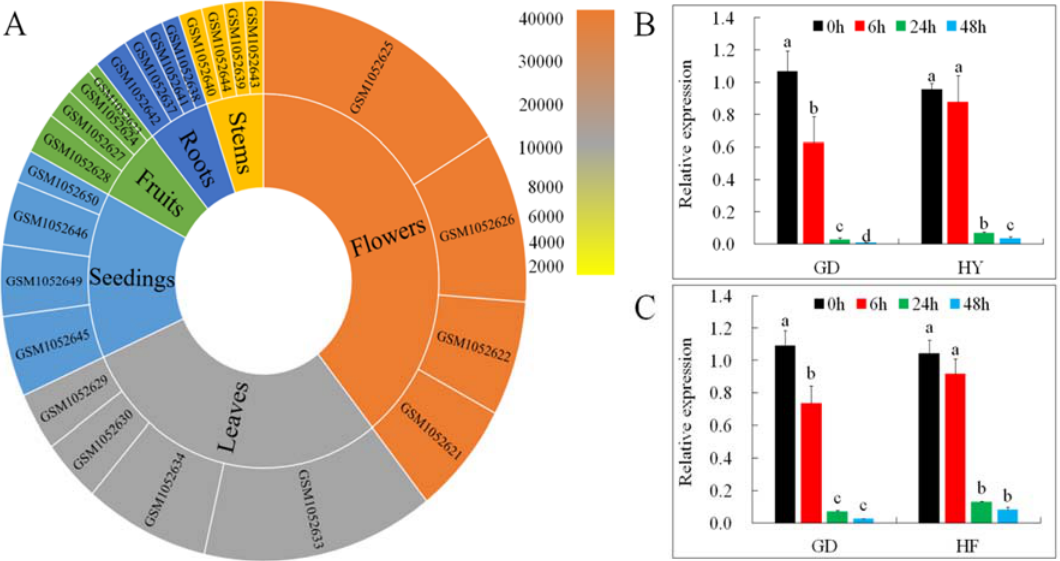
Figure 2. Expression patterns of MdMLP423 . ( A ) Expression patterns of MdMLP423 in root, stem, leaf, flowers, fruit, and seedings of Malus × domestica . ( B ) qRT-PCR of MdMLP423 ‘GD’ and ‘HY’ cultivars at 0, 6, 24, and 48 h post-inoculation with Botryosphaeria berengeriana f. sp. piricola (BB). ( C ) qRT-PCR of MdMLP423 at 0, 6, 24, and 48 h post-inoculation with Alternaria alternata apple pathotype (AAAP). The different lowercase letters indicate significant difference at p < 0.05.